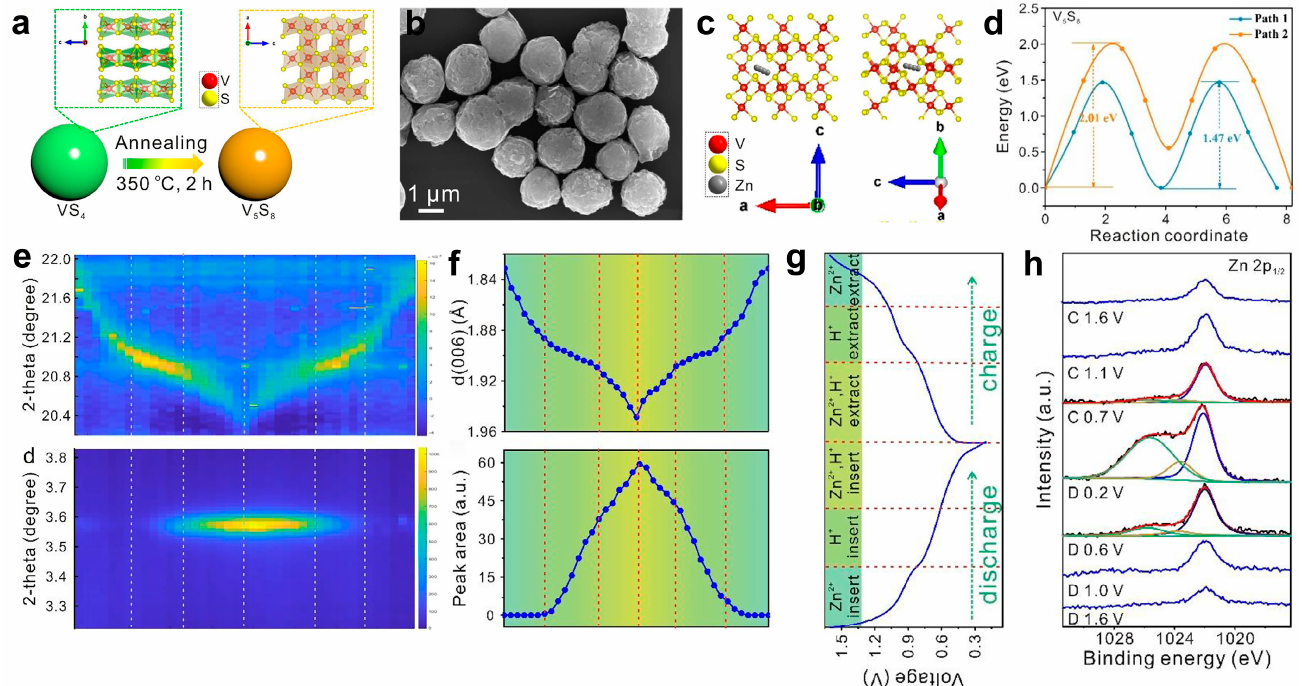
Figure 6. ( a ) Diagram of the preparation process of V 5 S 8 [71]. ( b ) The SEM images of V 5 S 8 [71]. ( c ) Schematic diagram of the diffusion pathway of Zn atoms in the V 5 S 8 anode (path I and II) [71]. ( d ) The corresponding diffusion energy barrier curves for different paths in V 5 S 8 [71]. ( e ) In situ SXRD patterns of the V 5 S 8 (006) characteristic peak and V 5 S 8 (001) characteristic peak [71]. ( f ) Changes in the interlayer spacing of the crystalline surfaces associated with V 5 S 8 during discharge/charging and the corresponding peak area of the side reaction product Zn 4 SO 4 (OH) 6 · 5H 2 O [71]. ( g ) Dis- charge/charging curves in the voltage range of 0.2–1.6 V during the in situ observation [71]. ( h ) Ex situ XPS spectra of Zn 2p at selected states